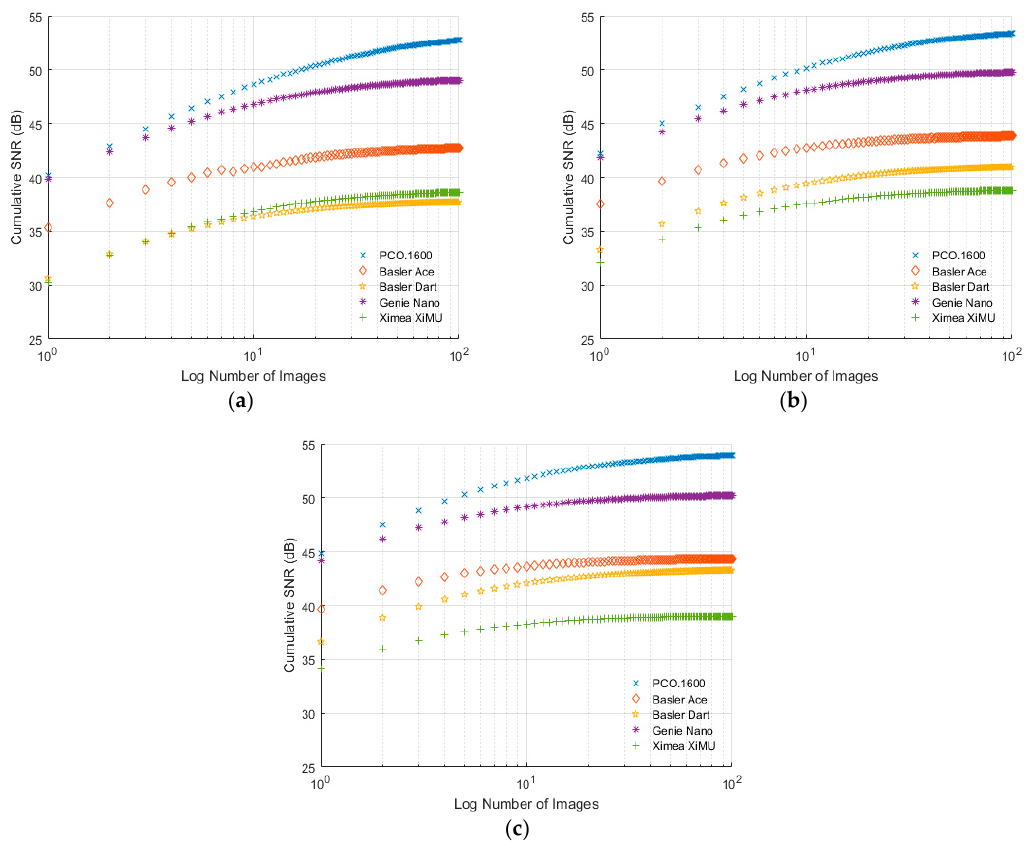
Figure 13. SNR for the different cameras measured with ( a ) 25% brightness, ( b ) 50% brightness and ( c ) 100% brightness.